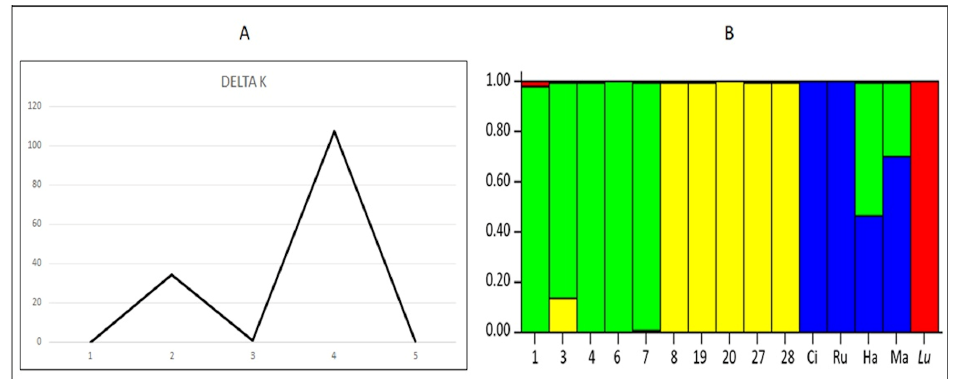
Figure 6. Bayesian clustering approach using all the evaluated genotypes ( P. coccineus , P. vulgaris and P. lunatus ). ( A ) result from the Evanno´s method, where K = 4 is the most likely number of genetic groups (largest delta K ). ( B ) The estimated membership probability for each line to each different group is shown in the vertical axis. 1, 3, 4, 6, 7, 8, 19, 20, 27 and 28 are lines of P. coccineus ; Ci : Cimarrón, Ru : Rubí; Ha: Hallado Alemán, and Ma : Mantenca are commercial varieties of P. vul- garis , and Lu is a line of P. lunatus .